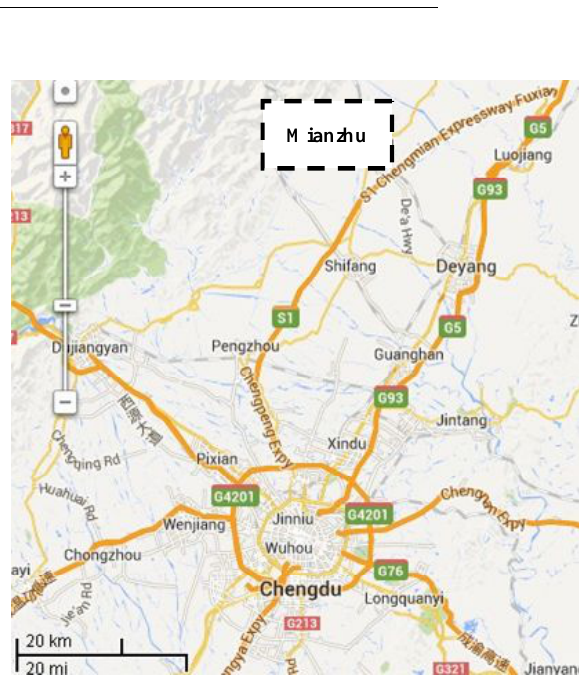
Fig. 1. The geographic location of the study area (from